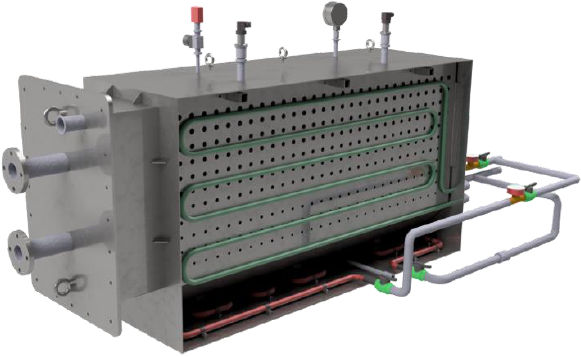
Figure 2. Lateral cross-section of reactor “all-in-one” configuration.